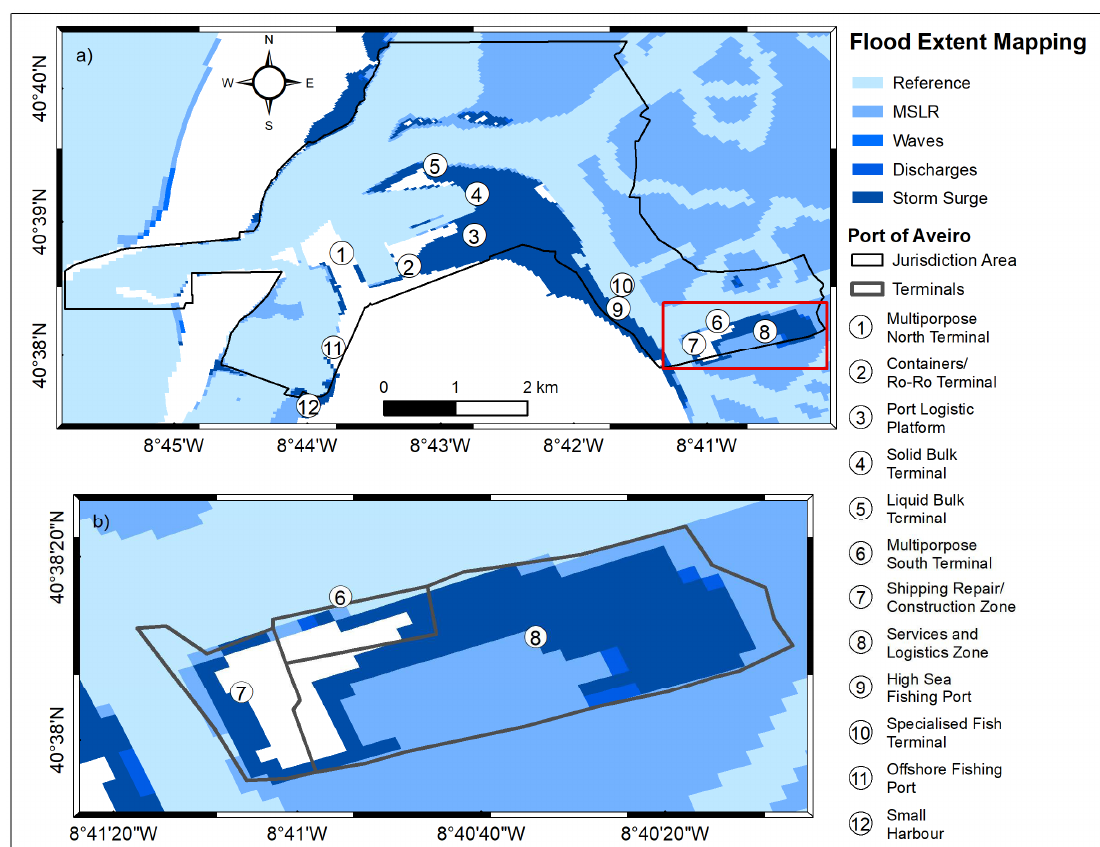
9 Figure 9. Flood extent mapping of the Aveiro Port’s terminals and zones (numbers 1–12) under its jurisdiction ( a ) (black line) and zoom of the most flooded area ( b ) (red line). Reference scenario and 100-year return period drivers for the far future (2081–2099) climate period, considering the climate drivers